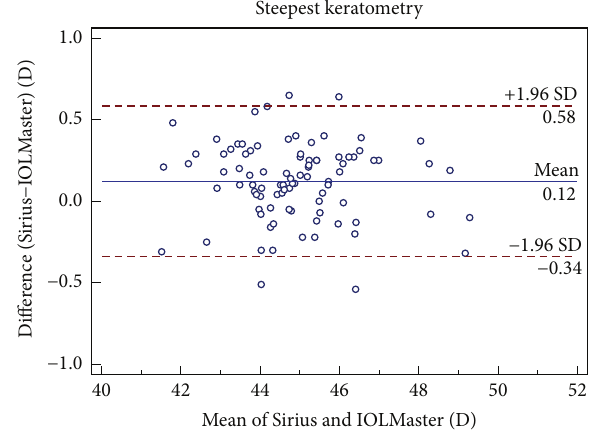
Figure 3: Bland-Altman plots of agreement of keratometry values along the steepest meridian taken with the Sirius Scheimpflug/ Placido photography-based topography system and IOLMaster partial coherence interferometry. The solid line indicates the mean difference (bias). The upper and lower lines represent the 95% limits of